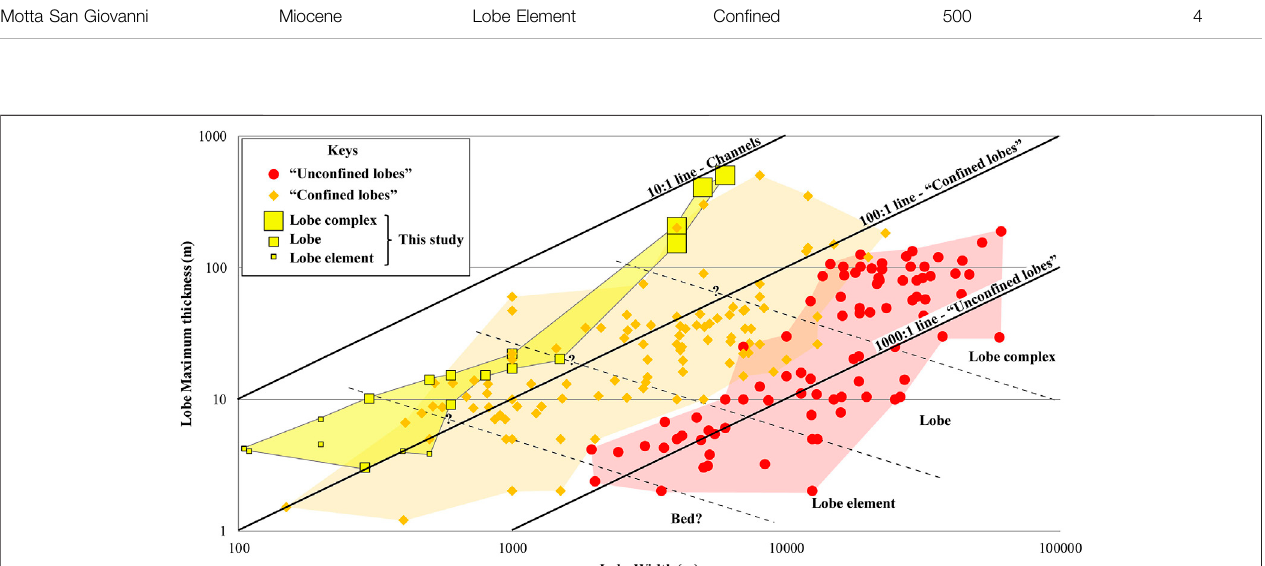
FIGURE 13 | Observed width vs. maximum thickness for studied lobes of the Motta San Giovanni Formation (green square), plotted on the log-log plot with con fi nedsystemsalignedona100:1line(diamondindifferentshadesofyellowish)anduncon fi nedsystemsalignedona1000:1line(dotindifferentshadesofbluish).10: 1 line illustrates the trend for channels (Pickering and Clark, 1996). Data are extracted from Pirmez et al. (2000), Bruhn et al. (2003), Moraes et al. (2004), Prélat et al. (2009, 2010, and reference therein), Etienne et al. (2012), Spychala et al. (2015), Marini et al. (2016), Picot et al. (2016, and reference therein), and Postma and Kleverlaan (2018), McArthur et al. (2021).